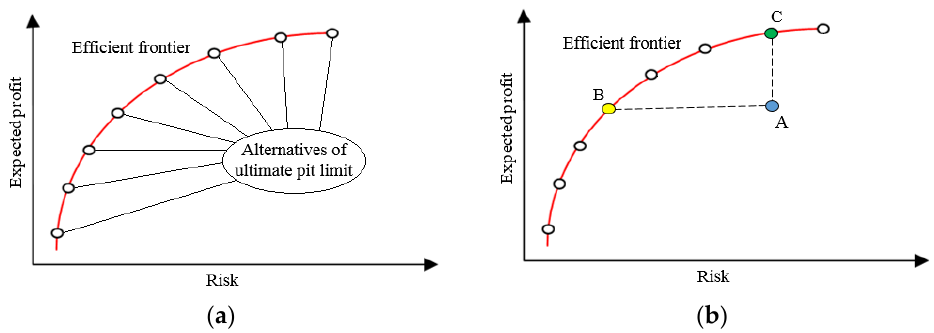
Figure 3. Efficient frontier in the expected profit vs. risk plane. ( a ) Each point represents an alternative to the final pit limit. ( b ) The feasible region under the frontier: point A represents a sub-optimal final pit decision, and points B and C on the efficient frontier are two better alternatives, in terms of risk and expected profit, respectively.